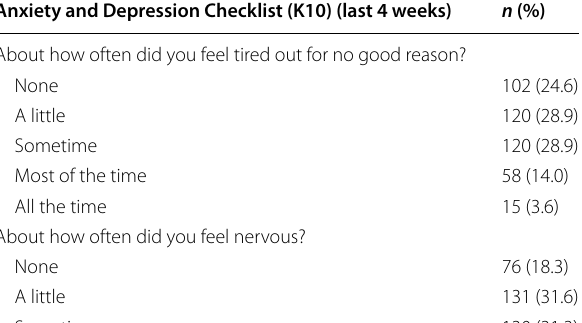
Table 2 Level of psychological distress among study sample